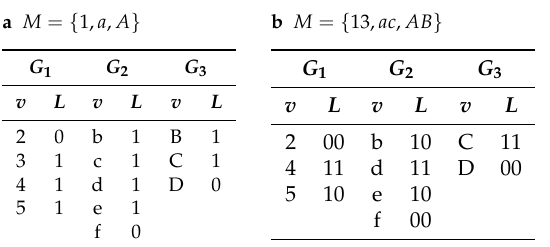
Figure 4. Three undirected and unlabeled graphs, G 1 , G 2 , G 3 , and one possible common subgraph computed by McSplit. Node labels, i.e., { 1,2,3,4,5 } , { a , b , c , d , e , f } , and { A , B , C , D } are reported to uniquely identify all vertices. Table 2. Labels on the non-mapped vertices of G 1 , G 2 and G 3 .